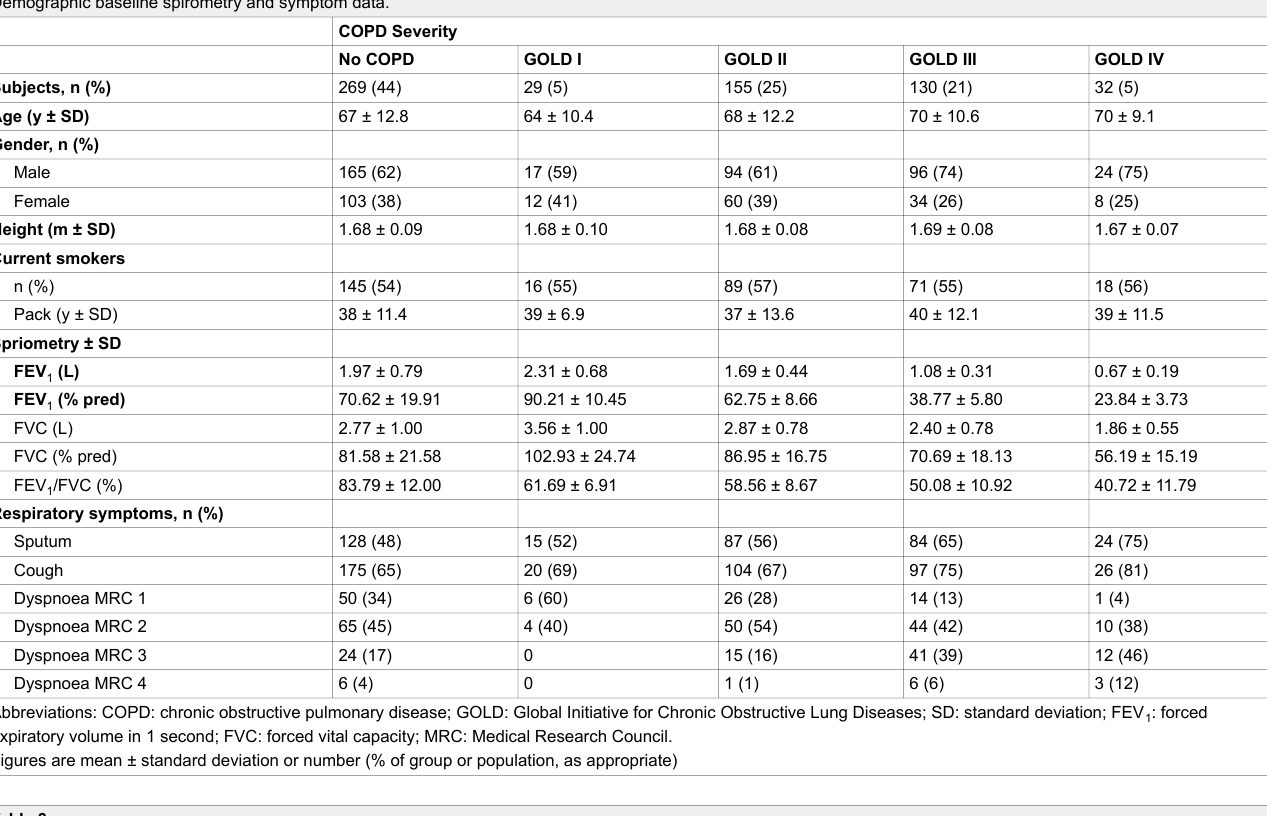
Table 3 Number of patients with indicators of past exacerbations.